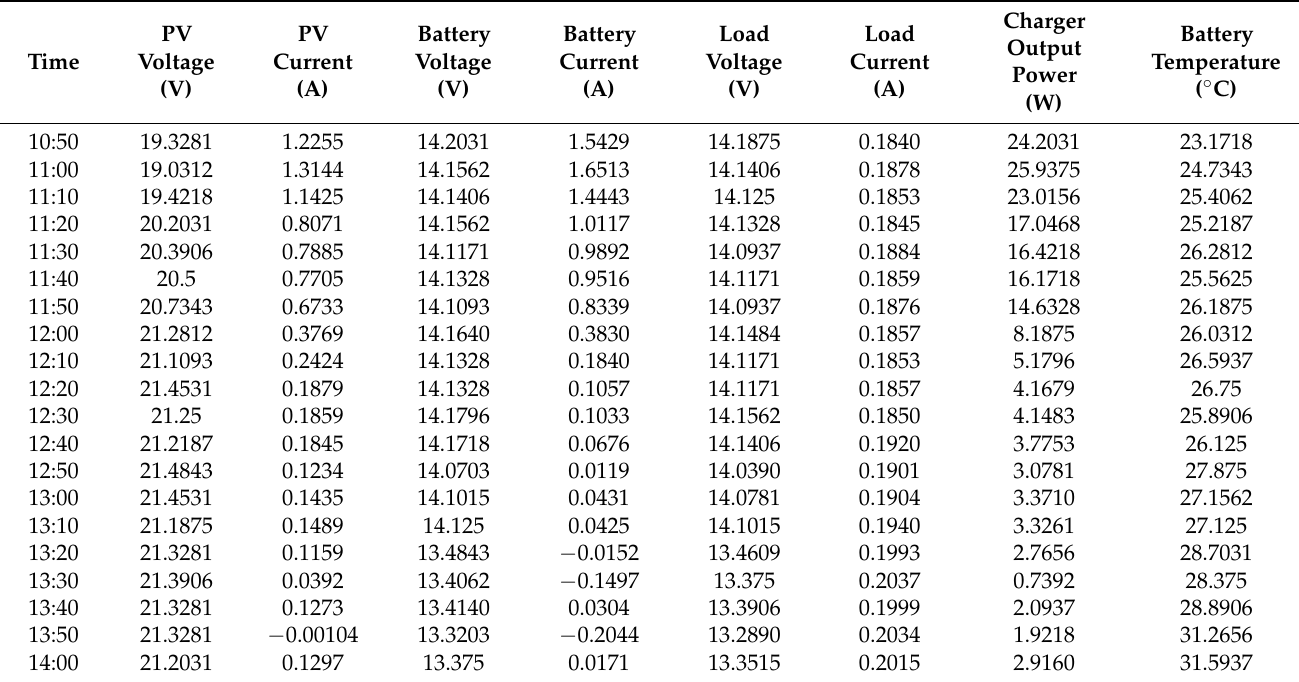
Table 3. Experimental Data for Solar Microgrid.